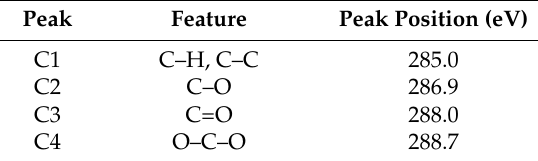
Table 5. XPS position of C1s features of plasma-modified rayon flock synthetic